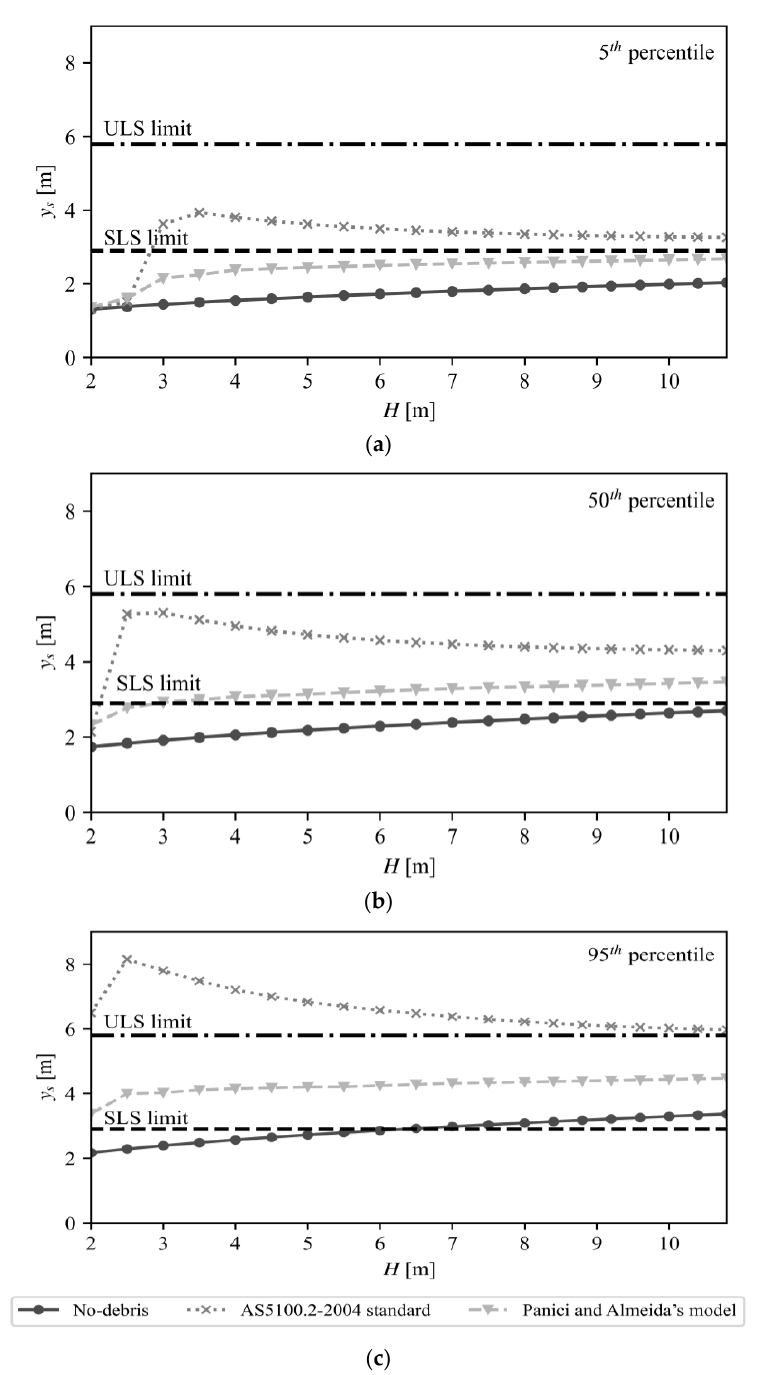
Figure 14. Representation of the ( a ) 5th percentile, ( b ) 50th percentile and ( c ) 95th percentile of scour depths ( 𝑦 𝑠 ) against the water heights ( 𝐻 ) for the three different scenarios and the upper prediction bound of the 𝐻 − 𝑣 relationship.